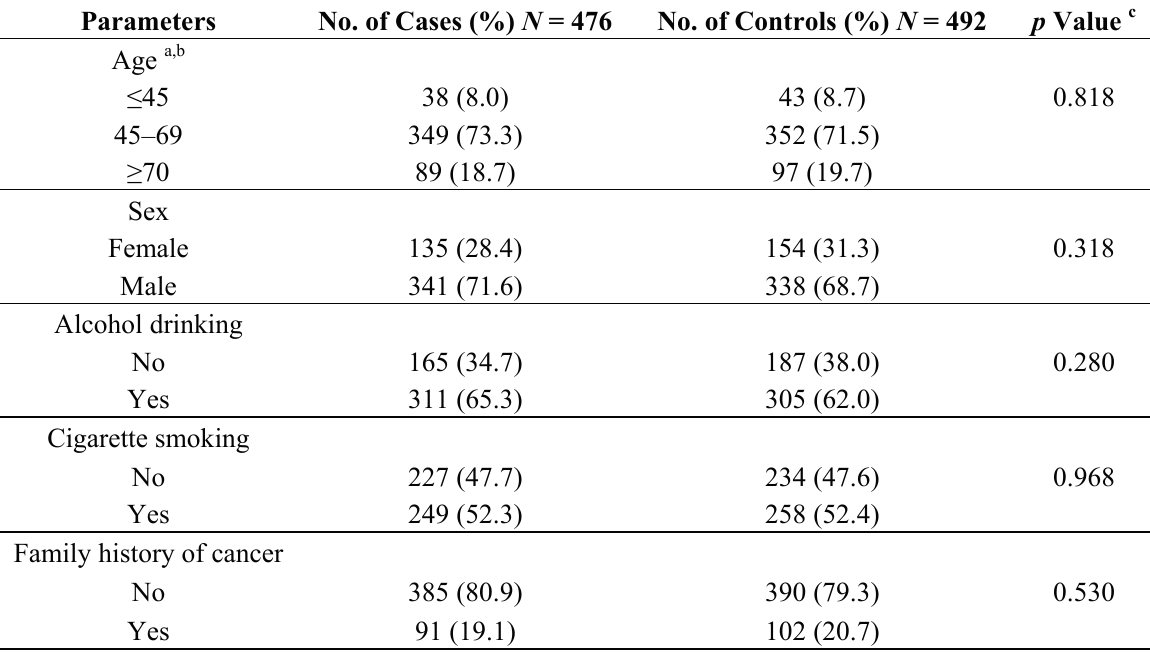
Table 1. General characteristics for the esophageal squamous cell carcinoma (ESCC) cases and control